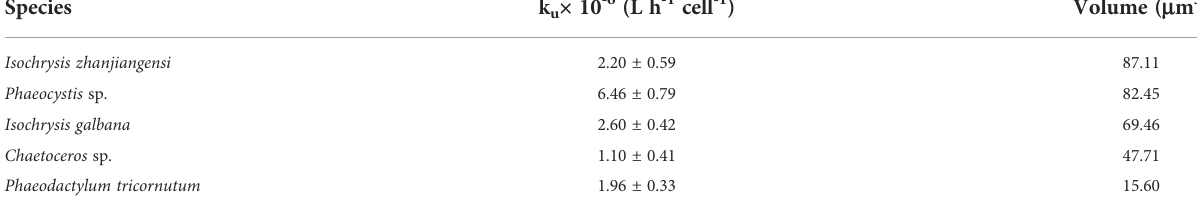
TABLE 1 Cu uptake rate constants (k u ) and volume ( m m 3 ) in fi ve marine phytoplankton species. Species